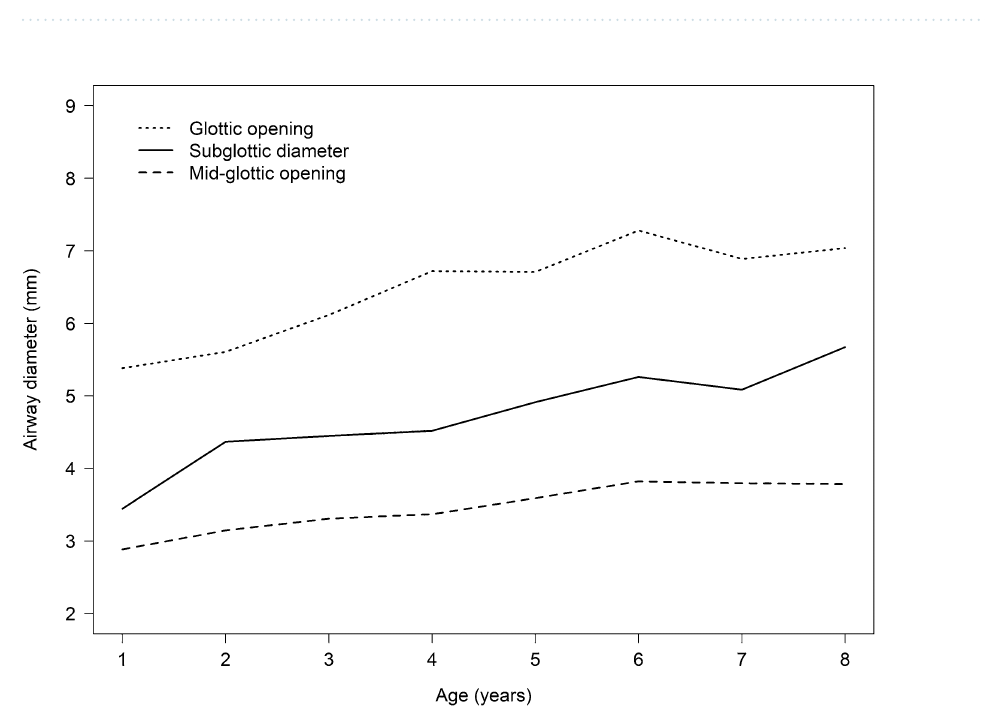
Table 2. Measurement of subglottic diameter, mid-glottic and glottic transverse diameter at the age of 1–8 years (N = 95). Data presented as median [interquartile range]. ETT endotracheal tube.